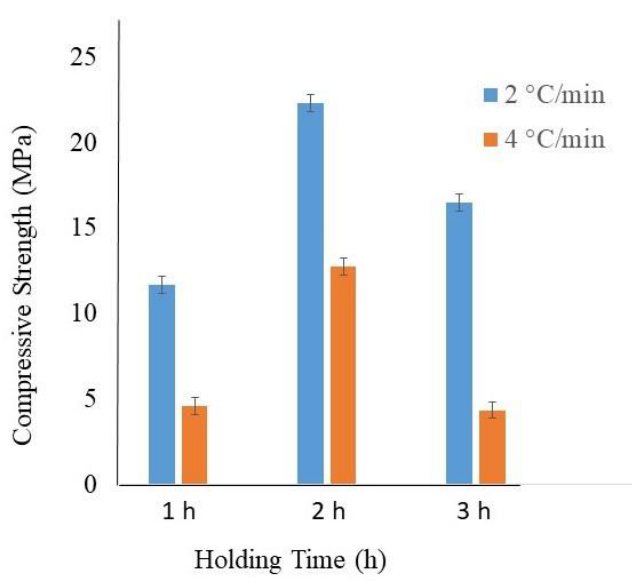
Figure 4. Compressive strength at different holding time (1 h, 2 h, and 3 h).